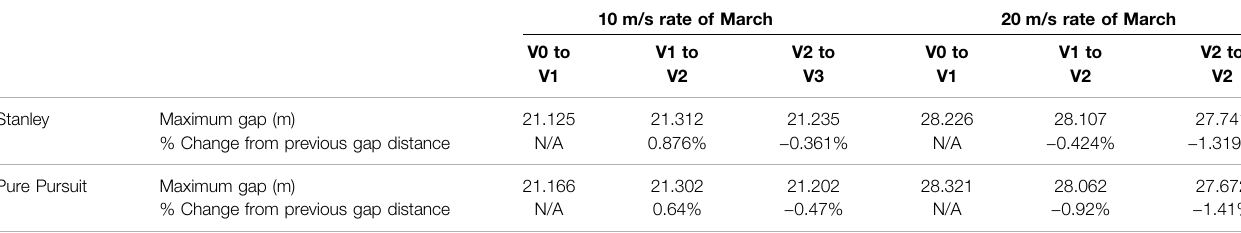
TABLE 6 | Maximum gap distance for different Rate of March settings.